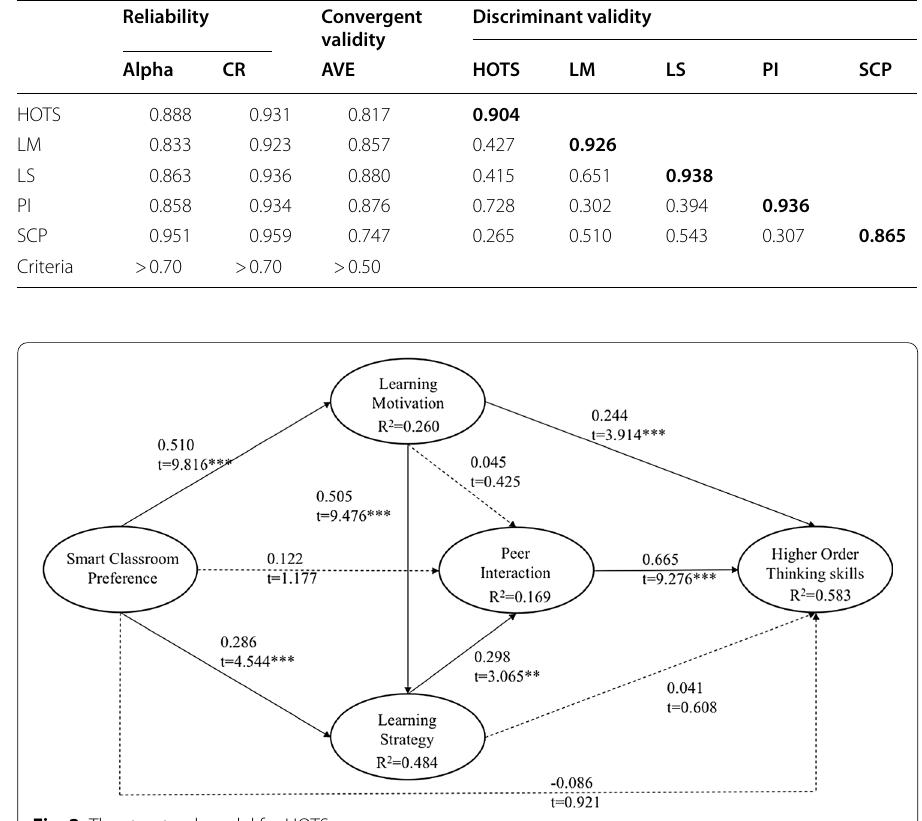
Fig. 2 The structural model for